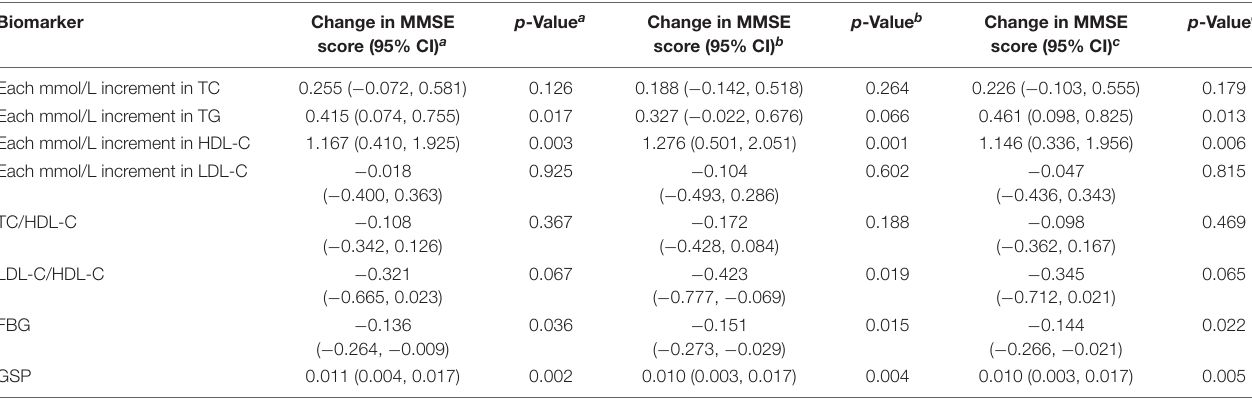
FIGURE 2 | The association between APOE , lipids, glucose, age, sex and cognitive function (MMSE continuous score). The results were from models for APOE , age, sex, and each lipids and glucose biomarkers separately; All models adjusted for age, sex, ethnicity, education, residence, marriage, exercise, smoking, drinking alcohol, BMI, and hypertension; Unit: year for age, mmol/L for TC, TG, HDLC, LDLC, and FBG, µ mol/L for GSP. TABLE 3 | The association between lipids, glucose and cognitive function (MMSE continuous